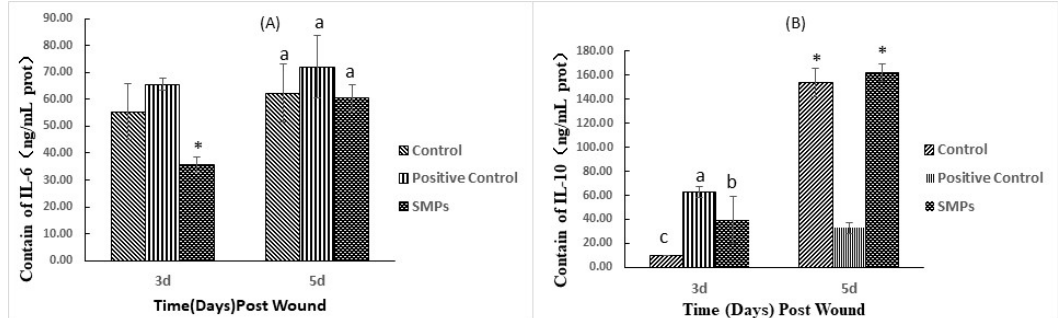
Figure 3. Effect of SMPs on inflammatory factors in wound skin tissue. ( A ) The content of IL-6 in the experimental group mice at three and five days after modeling. ( B ) IL-10 content in mice of the experimental group at three and five days after modeling. Different and same letters within the same row indicate significant ( p < 0.05 ) and insignificant different ( p > 0.05 ), respectively, * indicates a very significant difference ( p < 0.01).